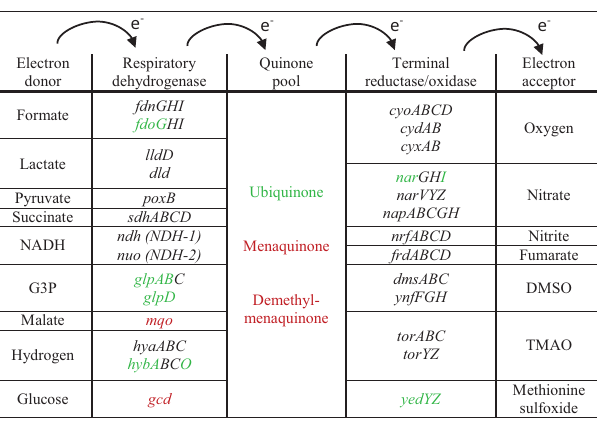
TABLE 6 | Summary of anaerobic respiration differentially expressed